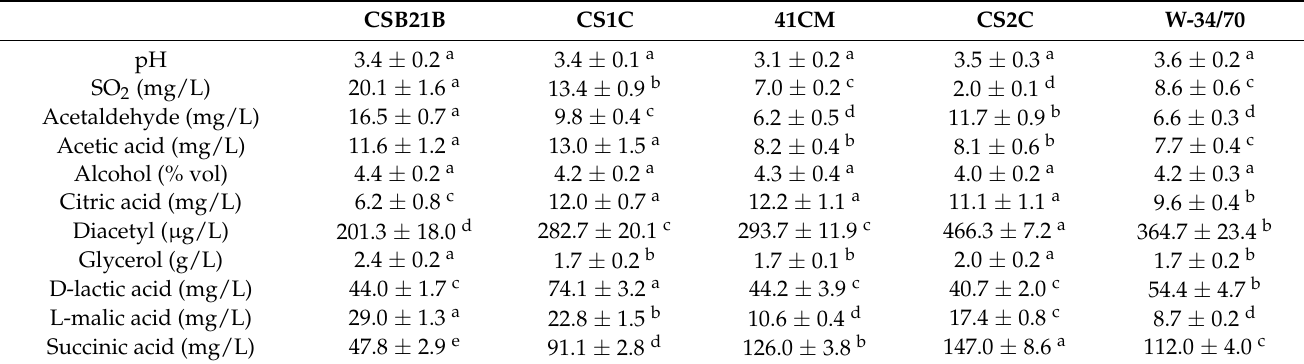
Table 3. Chemical characteristics of fermented products obtained by using S.cerevisiae CSB21B, CS1C, CS2C, 41CM and S. pastorianus W-34/70 as starter cultures. Data are expressed as means ± standard deviation obtained in three independent experiments ( n = 3); lower case letters indicate significant differences within row ( p <